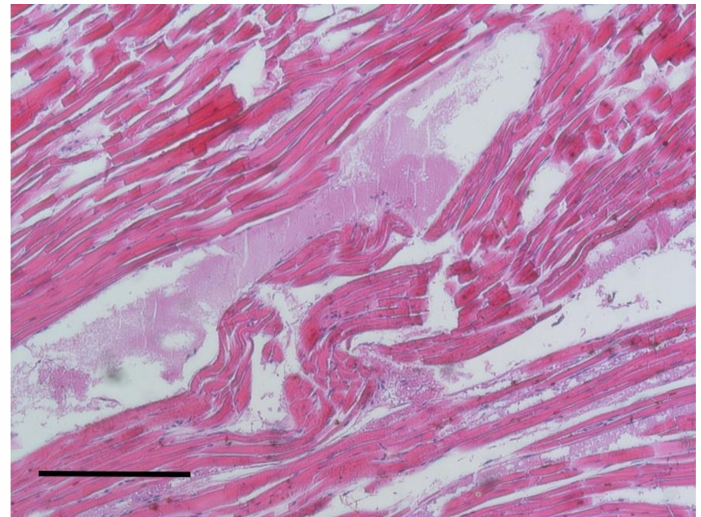
Figure 5. Heart. Disruption, fragmentation of muscle fibers and edema. H&E staining, bar = 100 µ m.